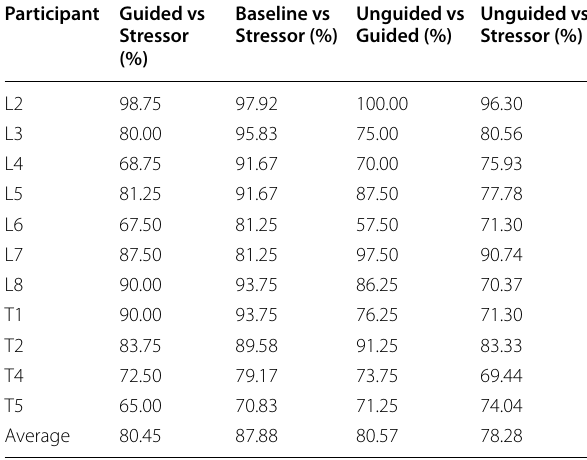
Table 1 Classification accuracies of the FBCSP‑SVM classifiers per participant and classification (‘Guided Breathing’ vs ‘Stressor’, ‘Baseline’ vs ‘Stressor’, ‘Unguided Breathing’ vs ‘Guided Breathing’, and ‘Guided Breathing’ vs ‘Stressor’) Participant Guided vs Stressor